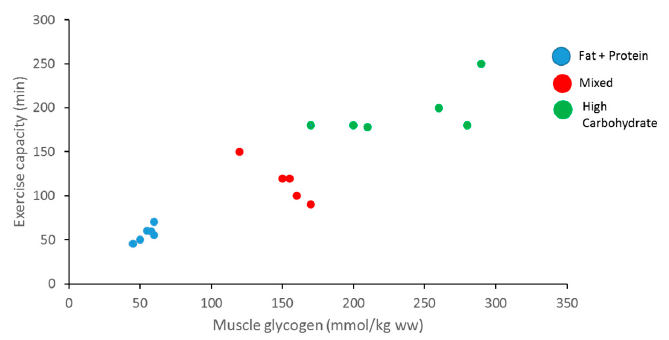
Figure 3. Relationship between muscle glycogen content, exercise capacity, and diet (adapted from Bergstrom et al., 1967).